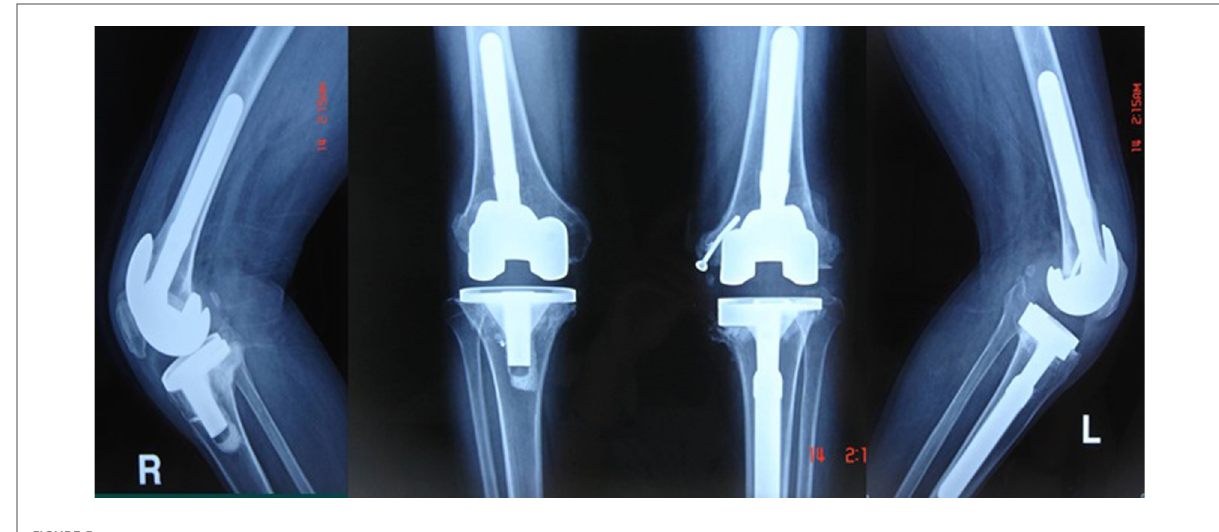
FIGURE 5 Radiograph of the anterior and lateral post-TKA positions after TKA, indicating that the position of the prosthesis was